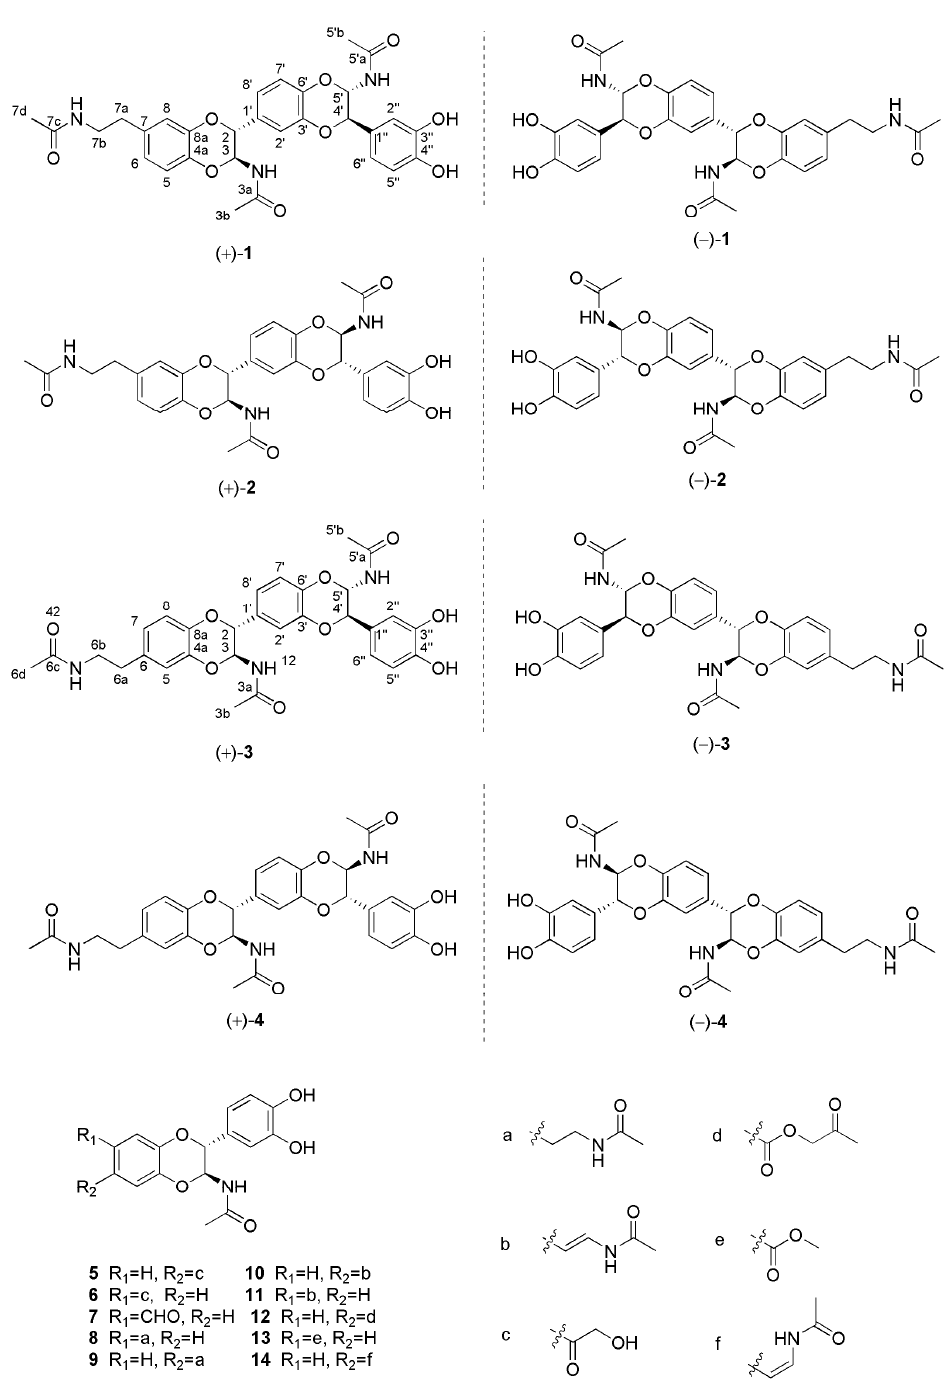
Figure 1. The chemical structures of the isolated compounds 1 – 14